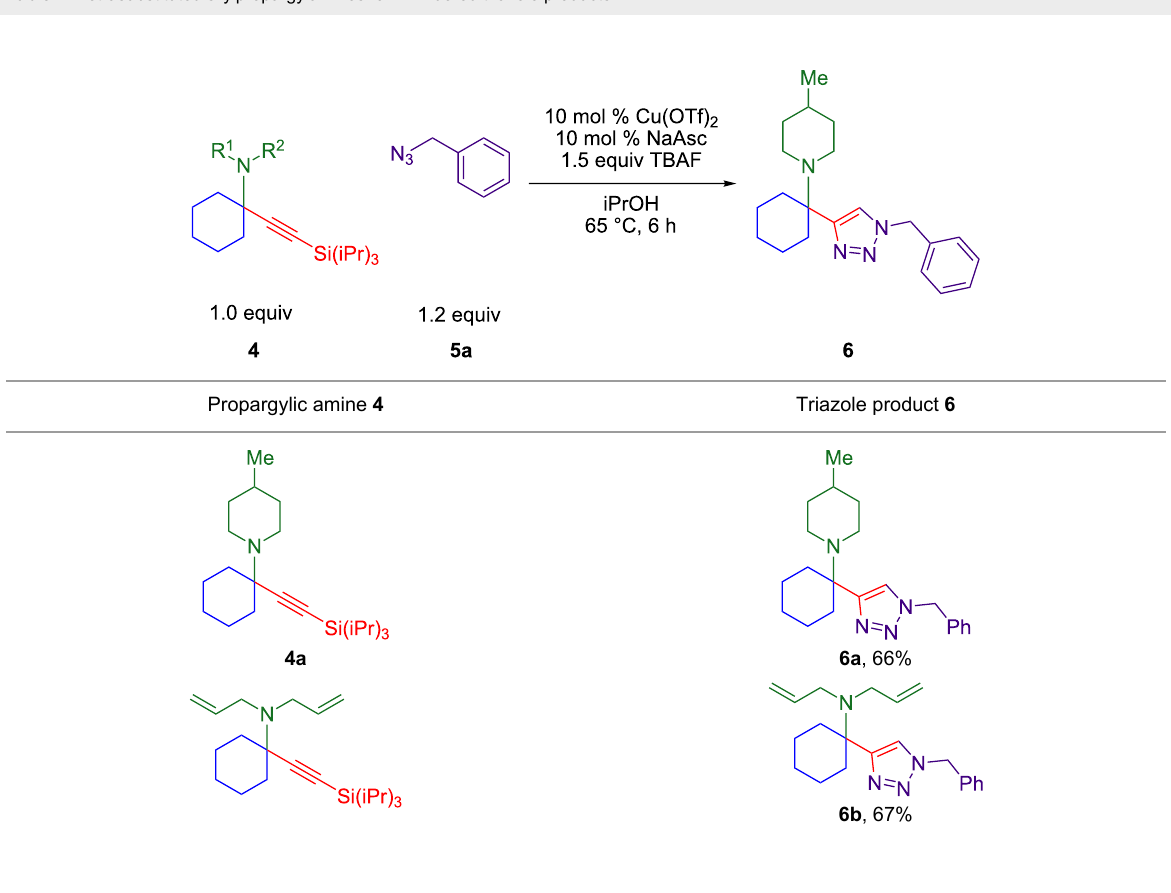
Table 2: Tetrasubstituted silylpropargylamines form hindered triazole